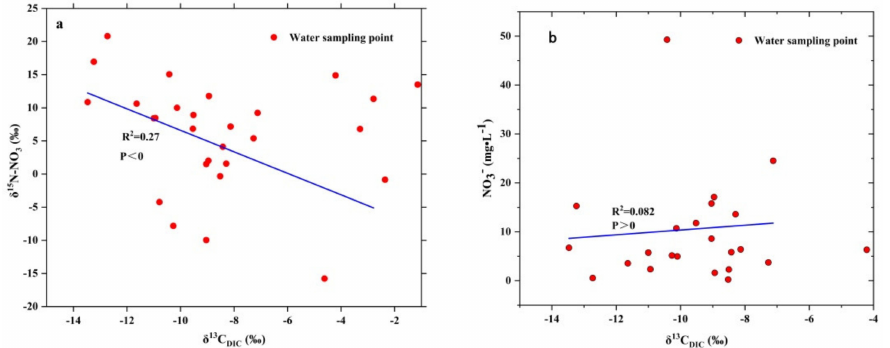
Figure 8. The relationship between δ 13 C DIC and δ 15 N-NO 3 ( a ) and NO 3 − ( b ) in the water body study area.